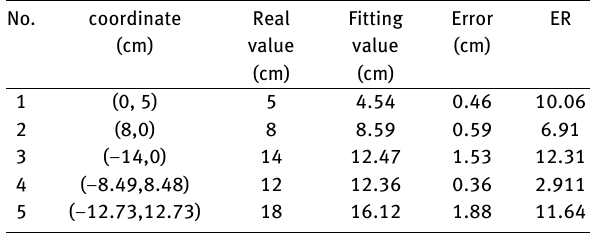
to the 2.1 section, the Db wavelet is changed to analyse those signals. As shown in Figure 6, the original signal col- lected by a strain gage, then it is denoised, decomposed and reconstructed by DB wavelet.